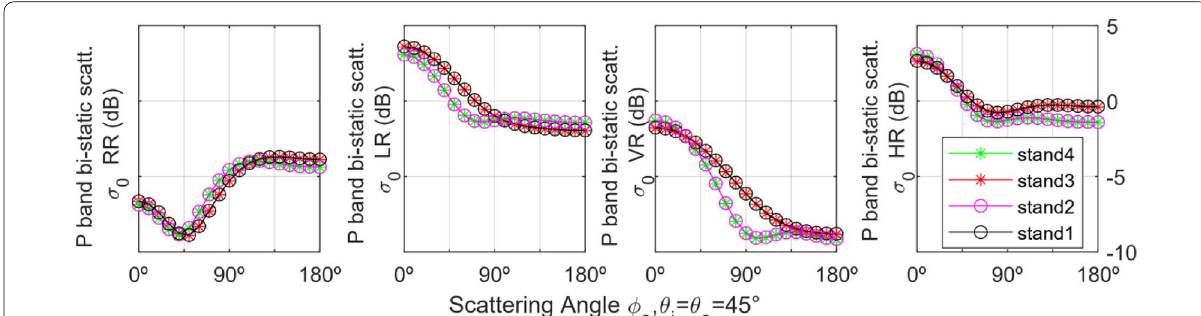
Fig. 11 P-band bistatic scattering for different polarizations for the 4 stands is shown in Table 3. The scattering geometry is a specular cone surface, θ